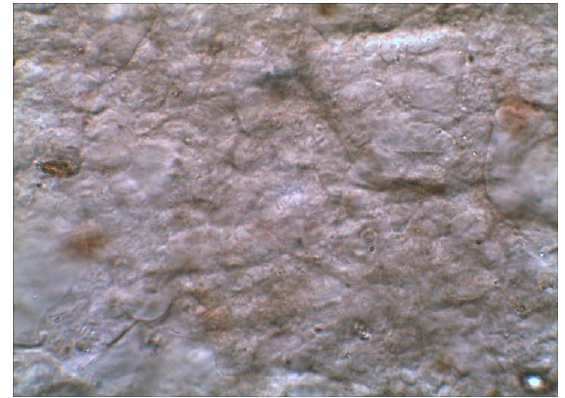
Рис. 1. Дисперсність гелю, що приготований при температурі 20 o C і 500 об/хв.,збільшення × 400